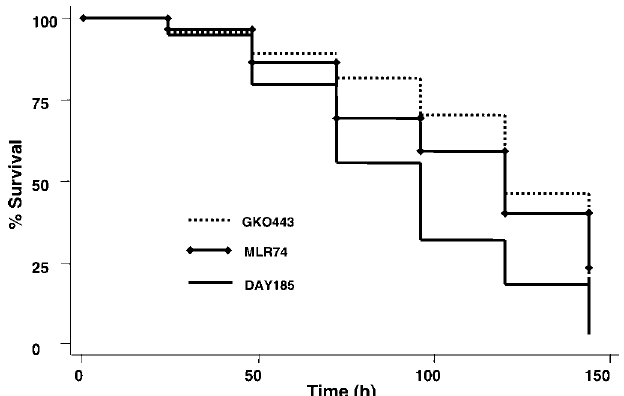
Figure 3. Candida Biofilm Formation and Filamentation Is Associated with C. elegans Killing Survival of C. elegans glp-4;sek-1 animals in liquid pathogen-free media after feeding for 2 h on C. albicans mutants with disruptions in kem1 (strain MLR74) or suv3 (strain GKO443). p ¼ 0.0008 and p , 0.0001, respectively, for the mutants compared to the parental strain C. albicans DAY185 ( ; 65 nematodes/group).